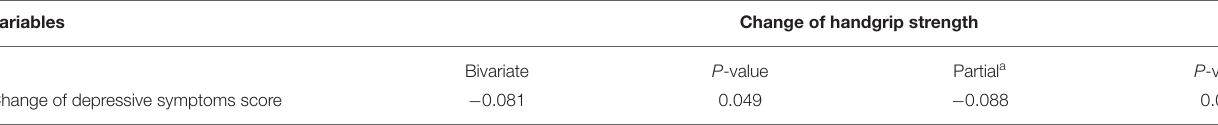
FIGURE 1 | Adjusted odds ratios (95% confidence interval) of associations of categories of handgrip strength change (kg) with depressive symptoms (SDS among Chinese college students. Model 1 adjusted for age (continuous variable); Model 2 adjusted for Model 1 change), change of drinking status (increase, decrease, no change), change of physical activity level (continuous variable), change of sleep quality (from good to bad, from bad to good, and no change), change of sleep duration (continuous variable) and change of BMI (continuous variable).